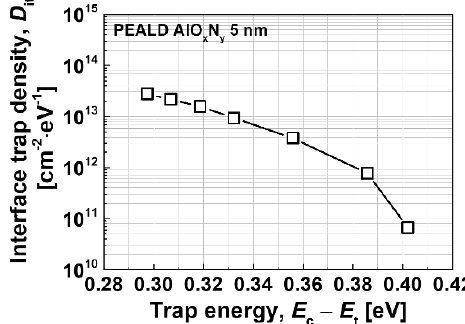
Figure 8. Interface trap density characteristics extracted by a conductance method.